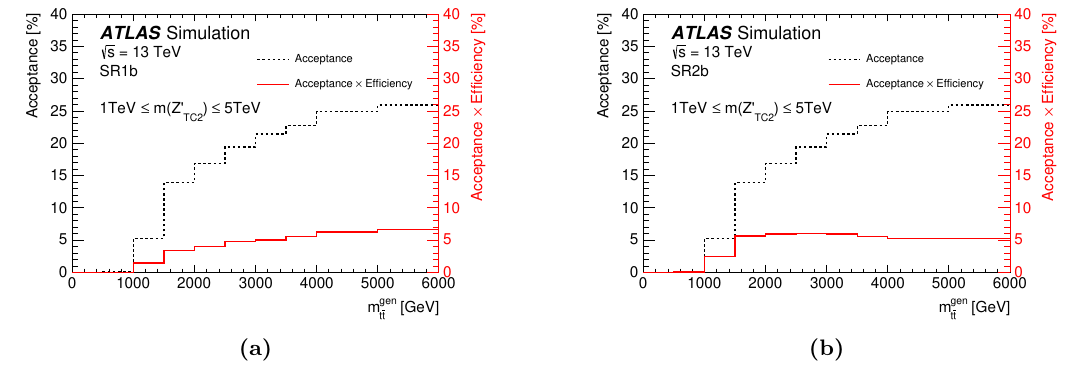
distributions for simulated Z 0 t (cid:22) t